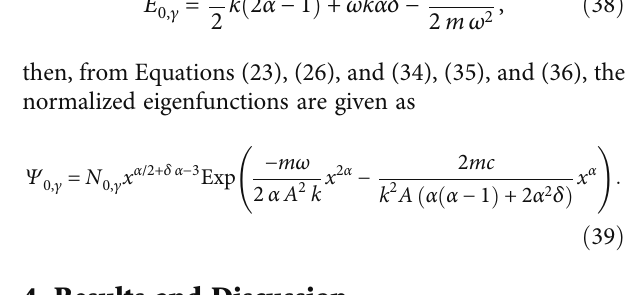
Table 5: Double charm and beauty baryon masses in the ground state (masses are in GeV) at ( α = β =0.1). Ref. Baryon P.W